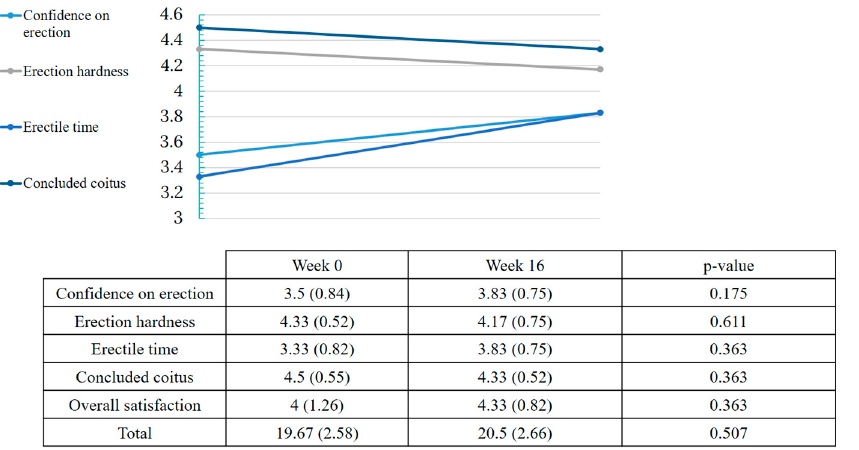
Figure 3. Effect of dupilumab on male sexual function. Values of total IIEF-5 and subcategories in weeks 0 and 16.